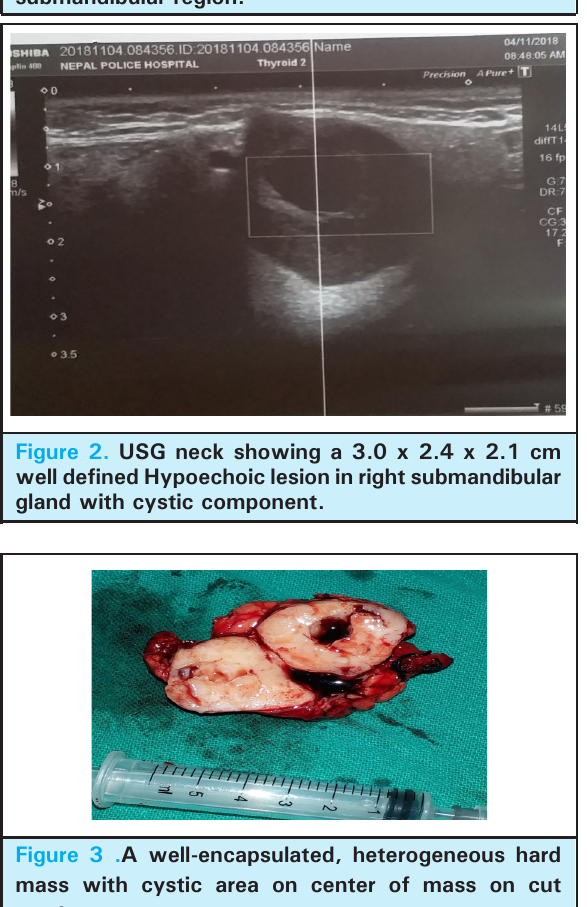
Figure 1. Facial profile showing swelling in the right submandibular region.